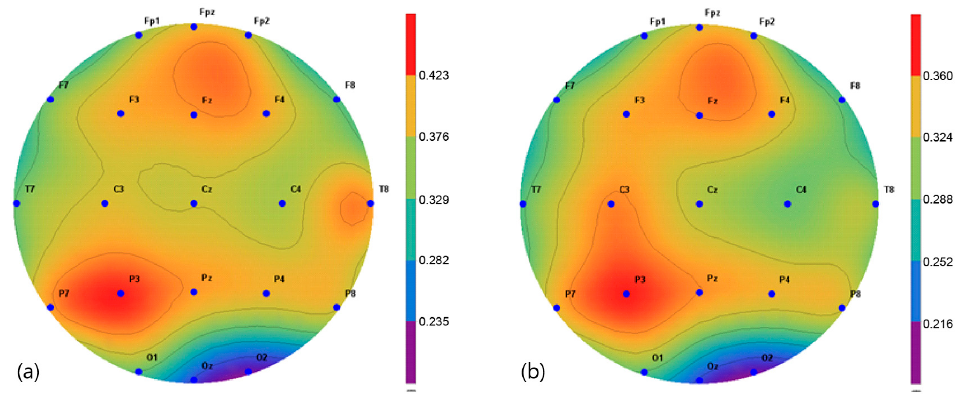
Figure 8. Mapping of the beta power value ( a ) before and ( b ) after training in the virtual reality-based bilateral arm training group.